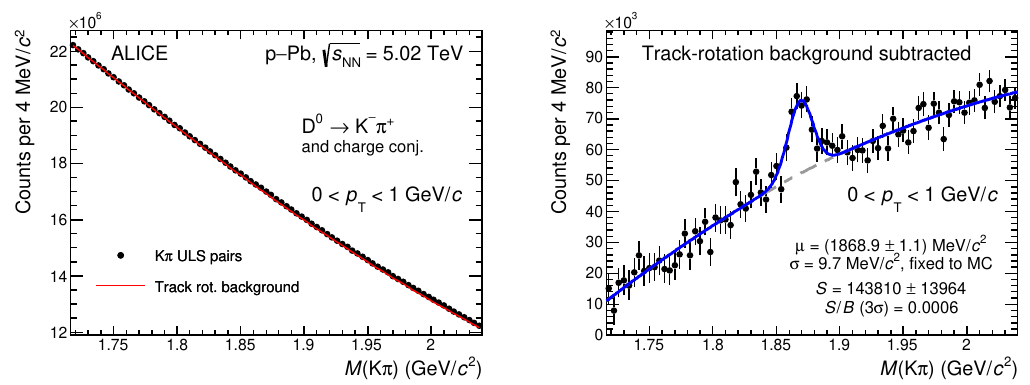
Figure 3 . Invariant-mass distributions of D 0 ! K (cid:0) (cid:25) + candidates (and charge conjugates) for 0 < p T < 1 GeV =c . The left panel displays the invariant-mass distribution of all ULS K (cid:25) pairs together with the background distribution estimated with the track-rotation technique. The right panel shows the invariant-mass distribution after subtracting the background estimated with the track-rotation technique. The (cid:12)t function is superimposed.